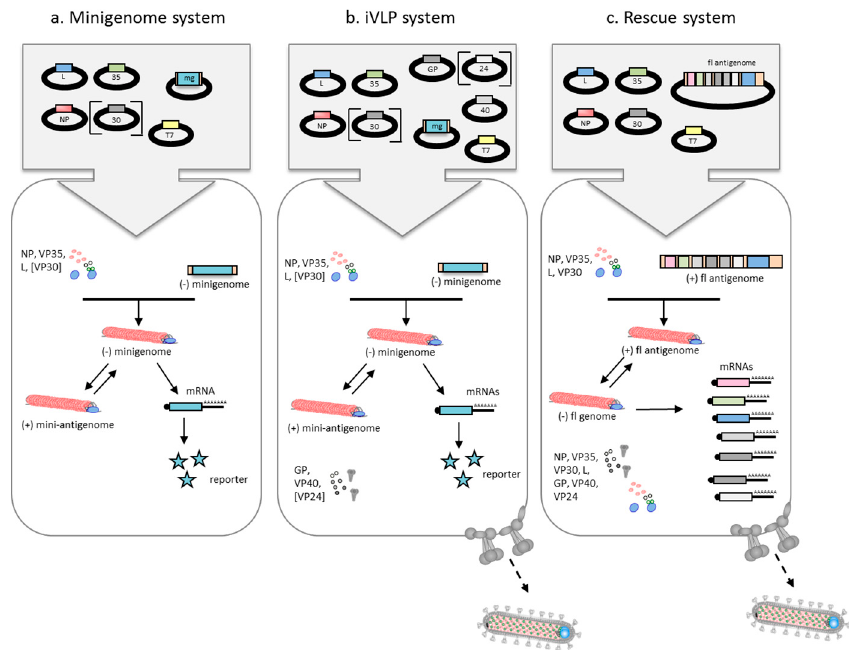
Figure 3. MARV reverse genetic systems. ( a ) Minigenome system; ( b ) infectious virus-like particles (iVLP) system; and ( c ) rescue system. In all systems, cells are transfected with the expression plasmids for the nucleocapsid proteins (NP, VP35, VP30, large protein (L)). For the iVLP system, the expression plasmids for GP, VP40 and VP24 are also included to facilitate budding. Viral proteins, which are not essential for the respective system, are bracketed. The T7 RNA polymerase (T7), which is required for the expression of the minigenome (mg), the full ‐ length antigenome (fl antigenome) and, depending on the plasmid backbone, for the expression of the support proteins, can be provided by using T7 ‐ expressing cells, infection with T7 ‐ expressing viruses or by transfecting a T7 expression plasmid. ( a , b ) Minigenomic or ( c ) antigenomic cDNA is transcribed by T7 resulting in negative ‐ sense minigenomic RNA or positive ‐ sense fl antigenomic RNA. Encapsidation is mediated by the expressed viral nucleocapsid proteins. ( a , b ) The minigenome is replicated via a positive ‐ sense mini ‐ antigenome intermediate. Transcription of the minigenome leads to reporter gene expression; ( c ) The fl antigenome serves as the template for the production of viral genomic RNA which in turn is the template for viral mRNA as well as antigenome production. ( b , c ) In the iVLP and rescue systems, viral particles are released from the transfected cells. The iVLPs contain minigenome RNA, while the rescue system leads to the production of infectious MARV particles.